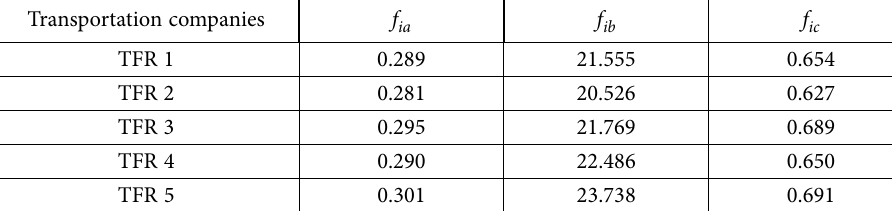
Table 15. Crisp Appraisal Scores Transportation